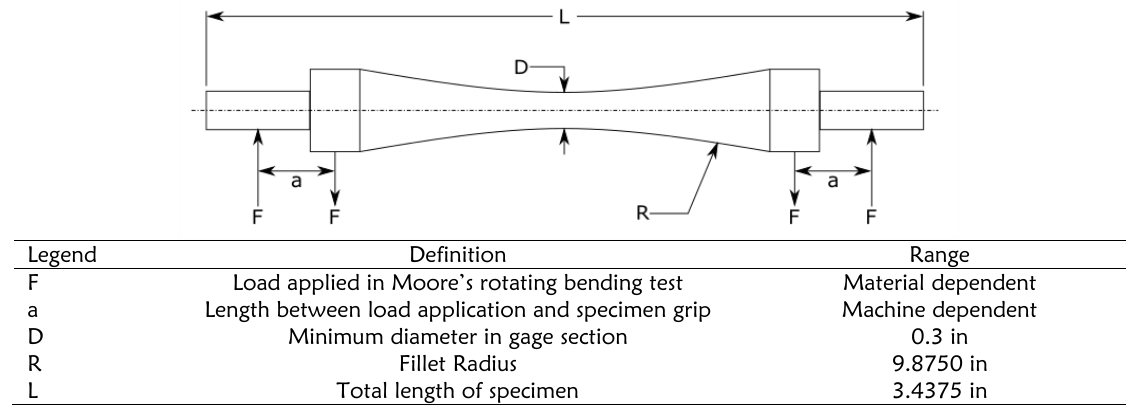
Figure 8: Specimen used for Moore rotating beam fatigue testing machine